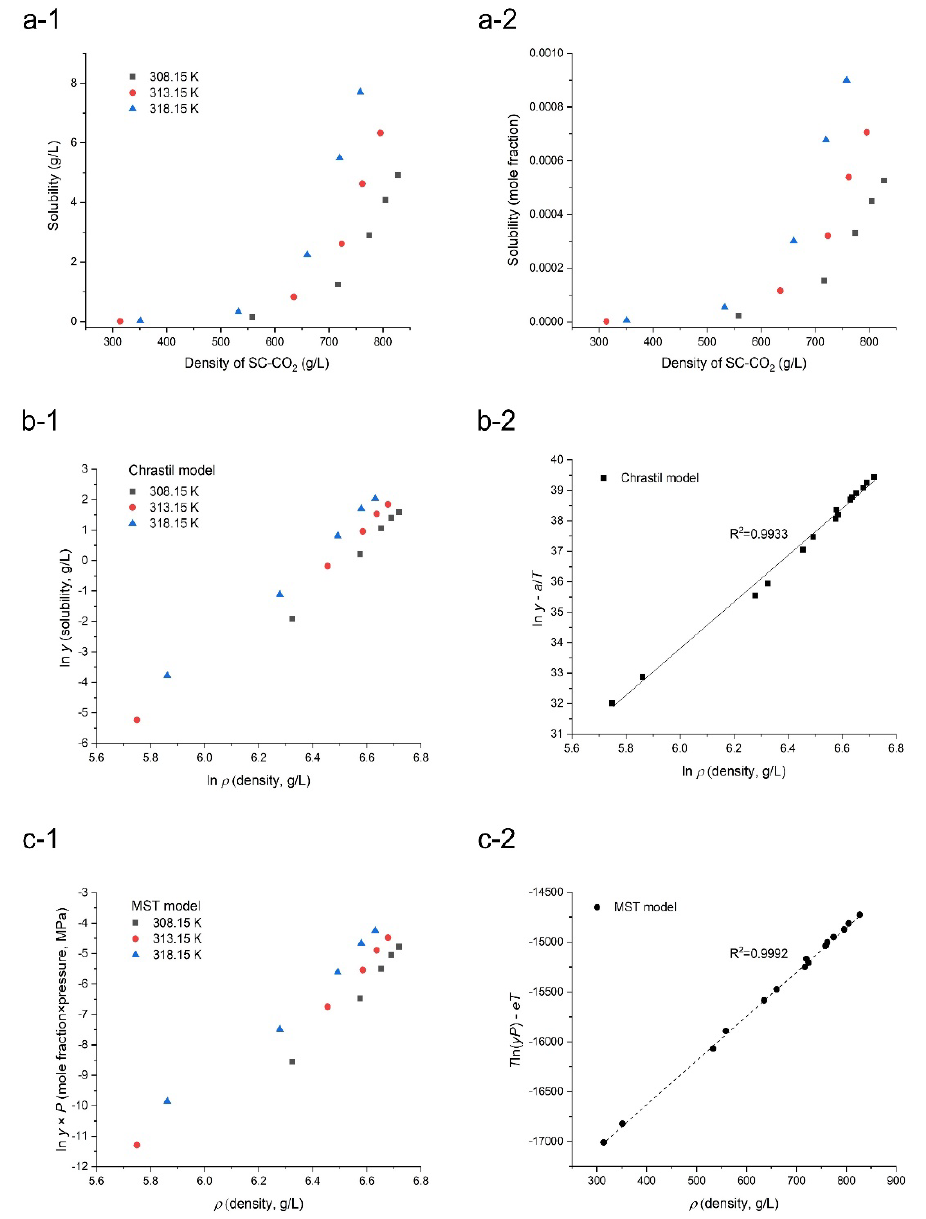
Figure 4. ( a-1,a-2 ) Dependency of the orlistat solubility (mean value, n = 3) on the density of SC-CO 2 and correlation of orlistat solubility in SC-CO 2 with two density-based models, ( b-1,b-2 ) Chrastil (solubility as a unit of g / L) and ( c-1,c-2 ) MST (solubility as a unit of mole fraction). Table 4. Correlation parameters and average absolute relative deviations (AARDs) of the two semi- empirical models (Chrastil model and MST model) to correlate experimental solubility data. 16.67 Méndez -Santiago and Teja (MST)